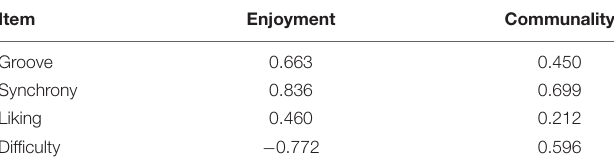
TABLE 2 | Item loadings for the Enjoyment factor (Exp.